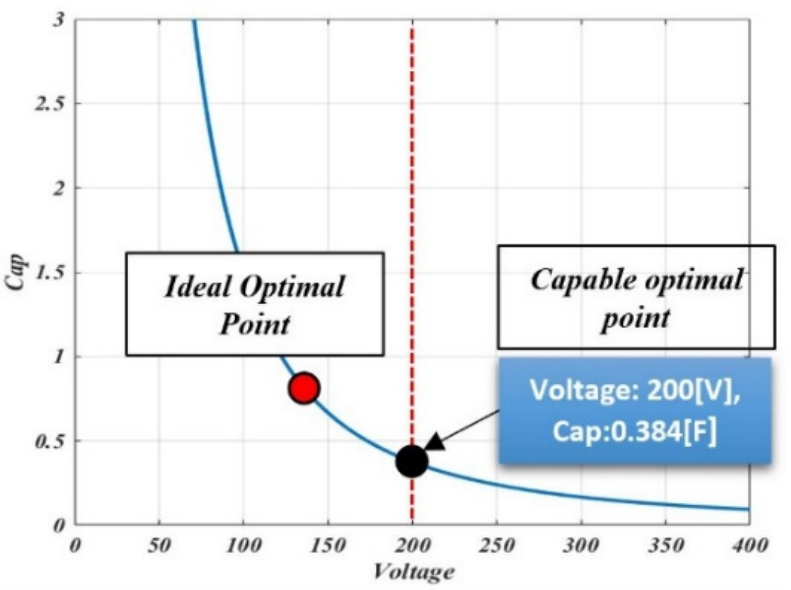
Figure 12. Calculation of compensation power supercapacitor.